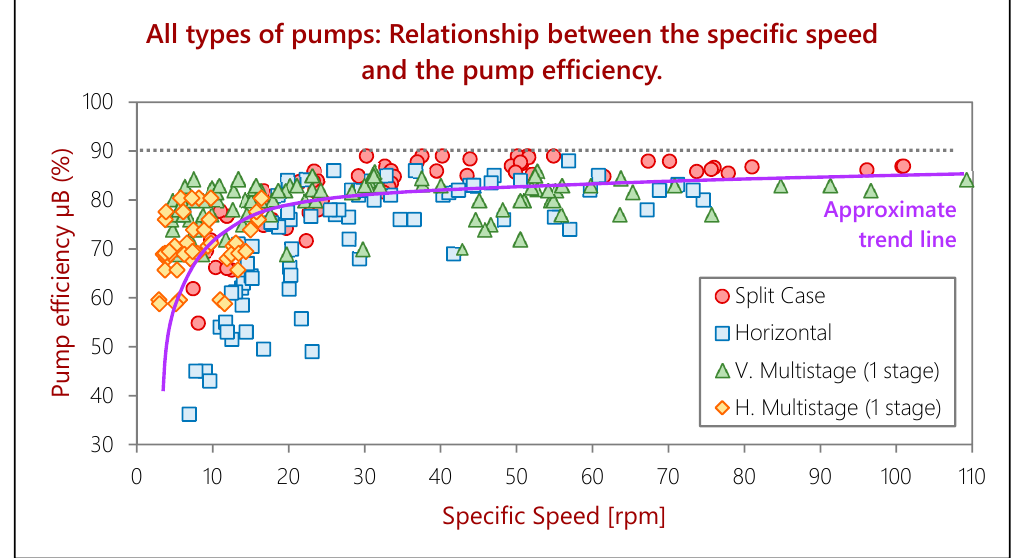
Figure 4. Optimum pump efficiency and the correspondent specific speed of the pump, classified by the pump type.